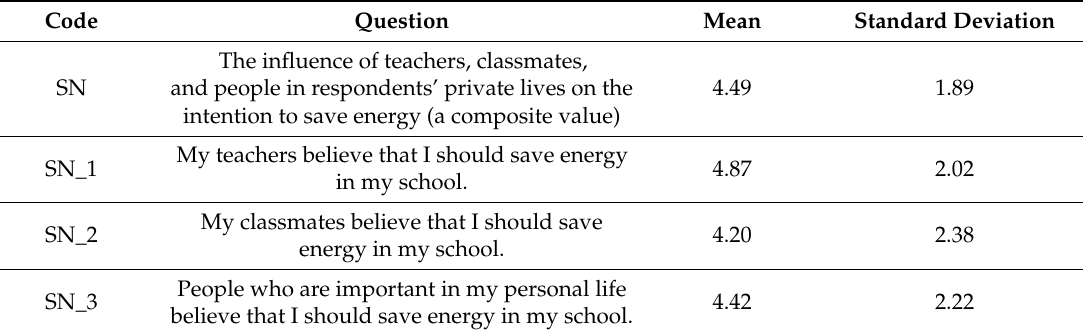
Table 8. Mean for subjective norms (totally disagree (1) to completely agree